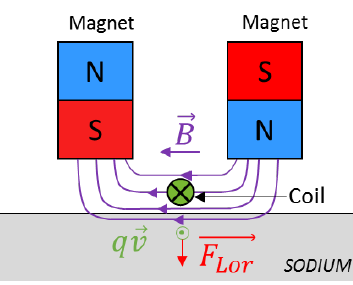
→ v is the electric current